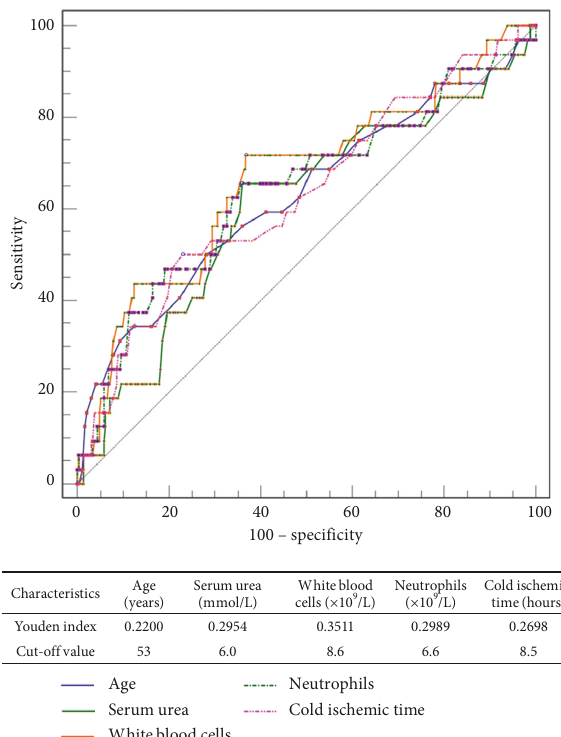
Figure 3: ROC curve and Youden index analyses of risk factors for survival in patients with HBV-ACLF following LT. Optimal cut-off values were determined by Youden index analysis. Table 3: Univariate and multivariate Cox proportional hazards models of factors associated with post-LTsurvival in HBV-ACLF patients.